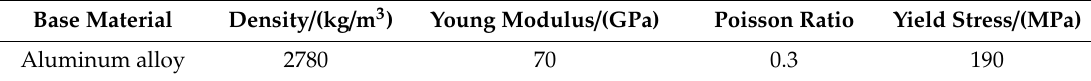
Figure 7. Finite element (FE) model of aluminum foam subjected to TNT charge. ( a ) Positive gradient specimen, g > 0; ( b ) negative gradient specimen, g < 0. Table 4. Parameters of the base material of aluminum foam [33].